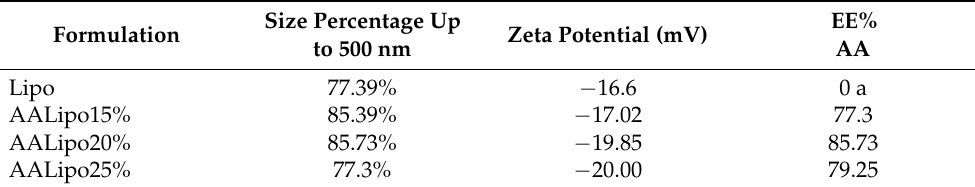
Table 1. DLS results (size distribution and zeta potential) and EE% of AA in liposomal formulas (AALipo15%, AALipo20%,